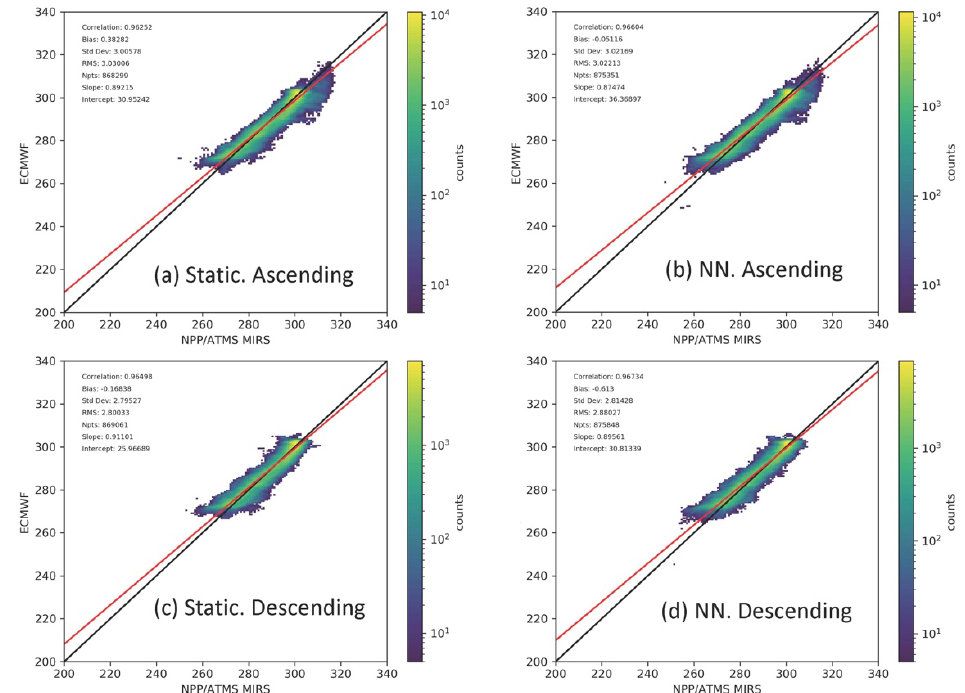
Figure 9. Skin temperature (K) scatterplots of SNPP / ATMS validated with ECMWF on 1 October 2019 over ocean, with ascending (top) and descending (bottom) nodes, using static (left) or NN (right) bias correction. The x-axis is MiRS skin temperature, and the y-axis represents ECMWF. The scatterplots are colored by the density of